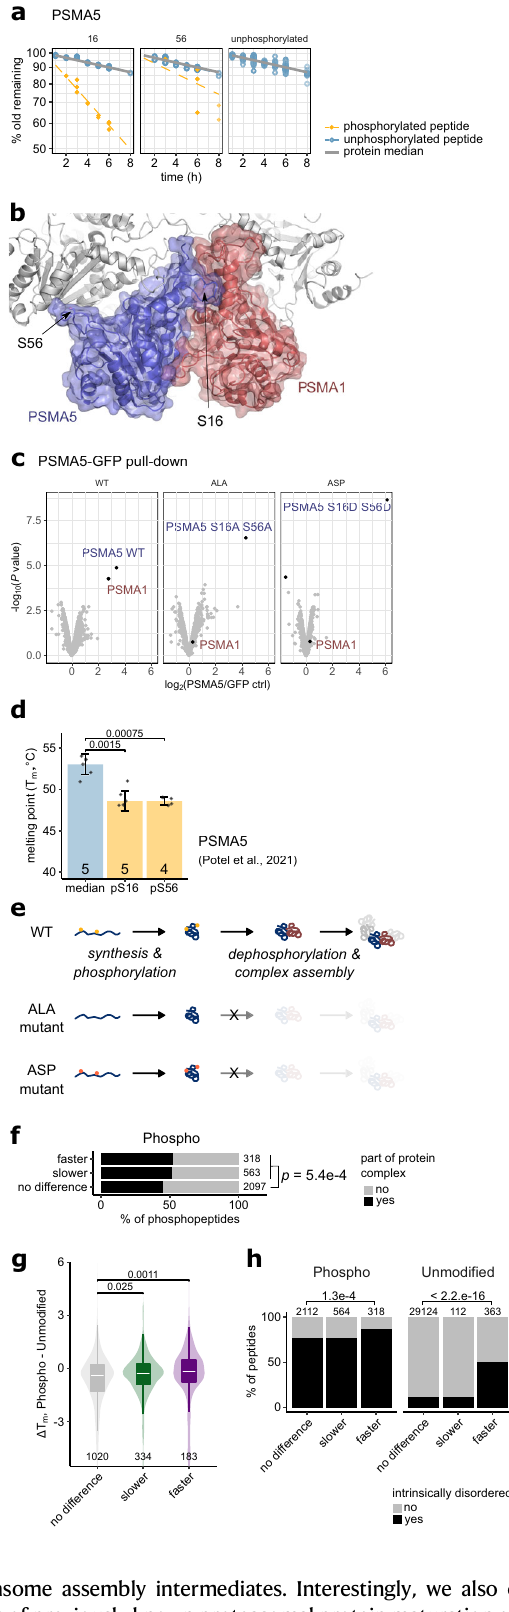
Fig. 6 | Transient phosphorylation at S16 on PSMA5 is needed for interaction with PSMA1. a Clearance pro fi les of PSMA5 peptides carrying S16 or S56 (yellow), aswellasallunphosphorylatedpeptides(blue)areshown. b StructureofPSMA5(in blue) in the mature proteasome. The neighboring alpha ring subunit PSMA1 is highlighted in red. S16 and S56 are highlighted as sticks. Both residues are unphosphorylated in the mature proteasome structure (PDB ID: 6MSB). c Pull- down under stringent buffer conditions (RIPA) of exogenously expressed PSMA5- GFP constructs in HeLa cells shows that the PSMA5-PSMA1 interaction is lost upon mutationofS16andS56.yaxis:unadjusted p valuefromalimmaanalysis. N =2.See also Supplementary Fig. 7a. d Thermal stability of peptides phosphorylated at S16 and S56 is signi fi cantly lower than the PSMA5 median suggesting a different bio- physicalstateforphosphorylatedPSMA5.Datafromref.27. t test(median-pS16: t = 4.75, df = 8.00; median-pS56: t : 6.88, df = 5.36). Error bars are SD. Number of individual replicates shown below. e Hypothesis for the role of S16 (and S56) phosphorylation. We hypothesize that transient S16 and S56 phosphorylation is required for PSMA5 maturation and its incorporation into the proteasome. f Phosphopeptides exhibiting differing clearance are enriched in protein complex subunits. Fisher ’ s exact test, two-sided. Protein complexes are from the CORUM corecomplexdataset 47 . g Phosphopeptideswithdifferingclearanceexhibitaltered thermal stability compared to the unmodi fi ed protein median suggesting altered molecular states such as protein – protein interactions. Proteome-wide thermal stability data from ref. 27. Two-sided Wilcoxon test. Boxplots consist of median line,box:upperandlowerquartiles,whiskers:1.5timesinterquartilerange.Outliers have been omitted for clarity. h Peptides with faster clearance are enriched in intrinsically-disordered protein regions. Disorder prediction from D2P2 (ref. 43). See “ Methods ” for details. Fisher ’ s exact test, two-sided. Source data are provided as a Source data fi